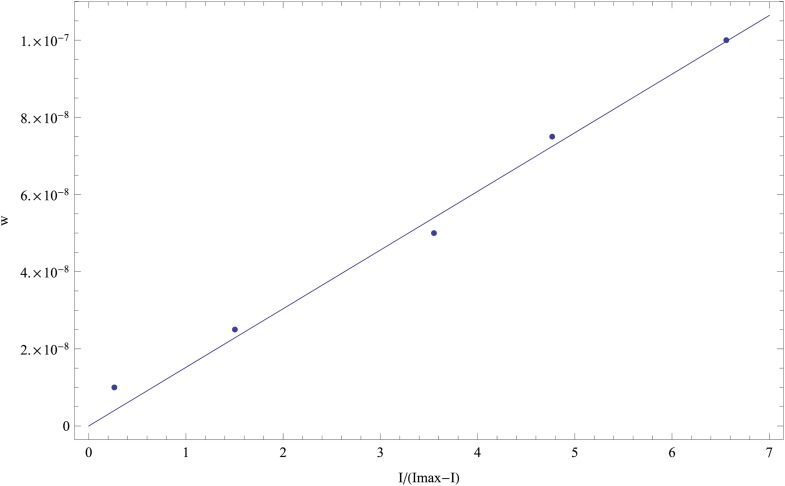
For the first replicate, we inferred a saturation value Imax = 15,631.Plotting w as a function of I/(Imax − I) we obtain an approximately linear relationship that also approximately goes through the origin (0, 0) (as it should).